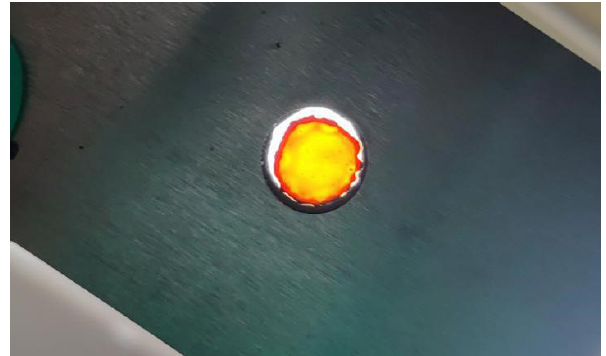
Figure 9. Test sample prepared by the dissolution method.